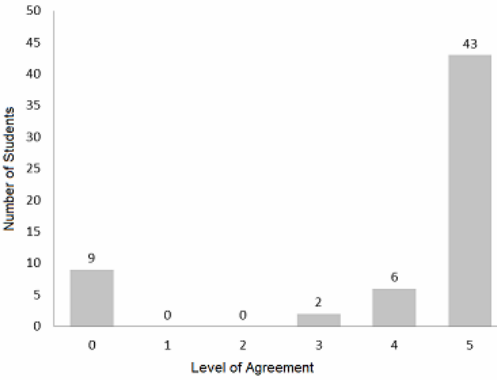
Figure 2. "Quizzes and assignments were essential"